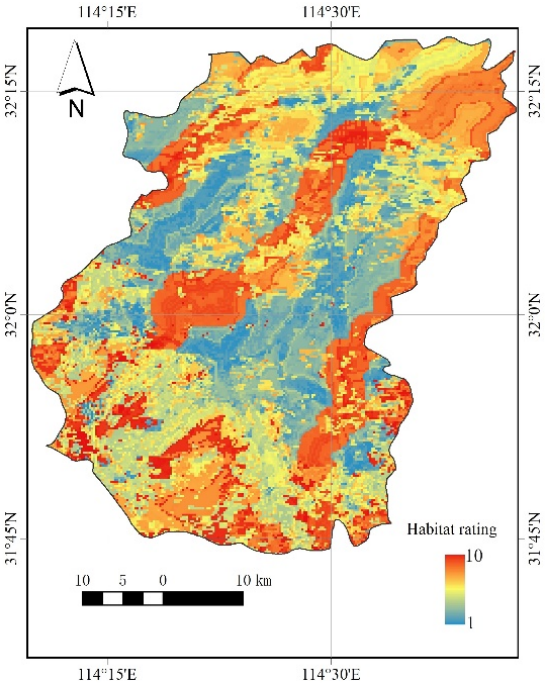
Figure 7. Crested Ibis habitat ‐ rating map. The red indicates the most suitable places for a high habitat ‐ rating; the blue indicates the least suitable places, for a low habitat ‐ rating.